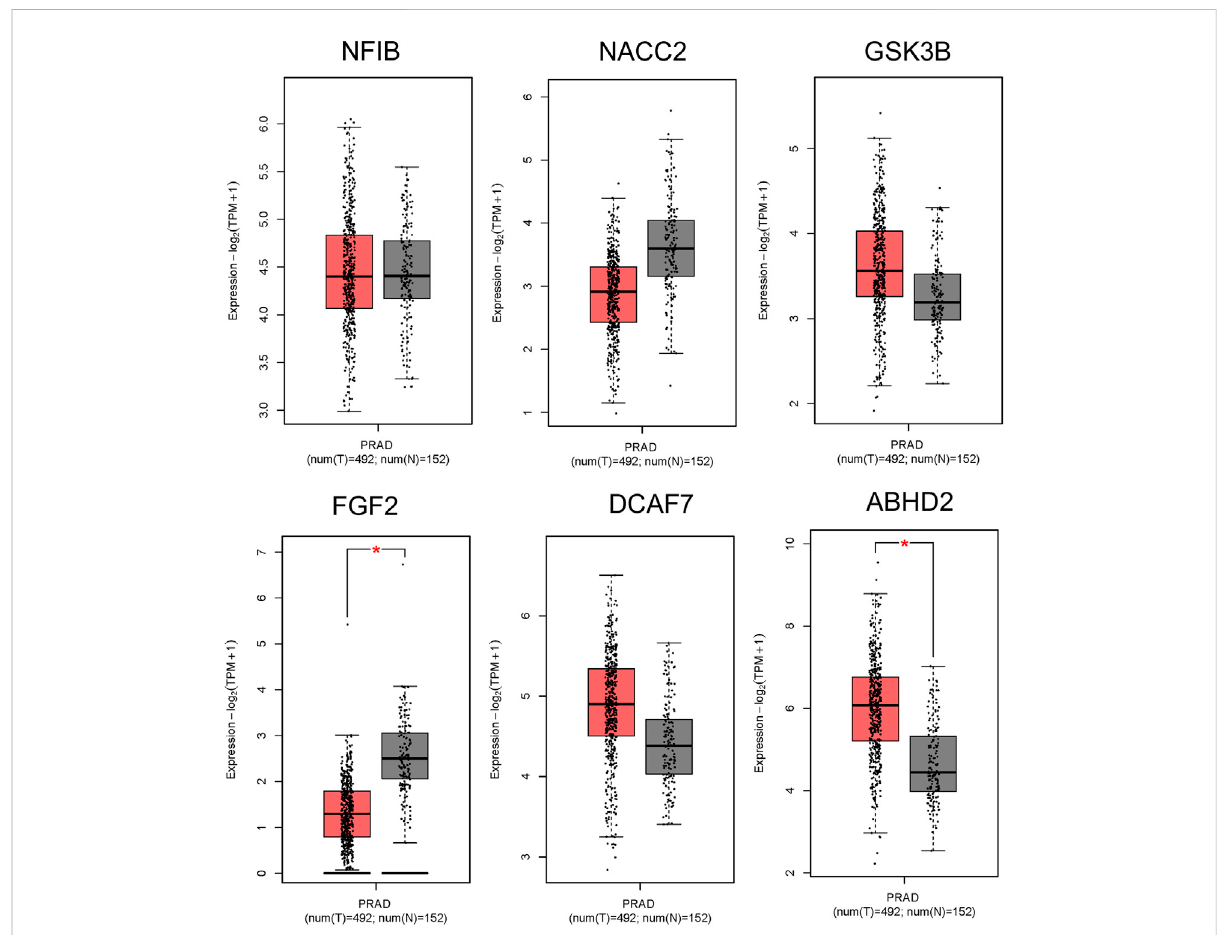
FIGURE 5 RNA Expression levels in PC in comparison to normal tissues from GEPIA2. The box plot representation for ABHD2, FGF2, DCAF7, GSK3B, NACC2, and NFIB . The signature score is calculated by mean value of log2 (TPM +1). The |Log2FC| cut-off of the expression of proposed biomarker was 1. The signi fi cant cut-off p -value of the expression of proposed biomarker was 0.01. The red box indicates the tumor samples while grey colour indicates the normal tissues. Each dot represents one sample data in the